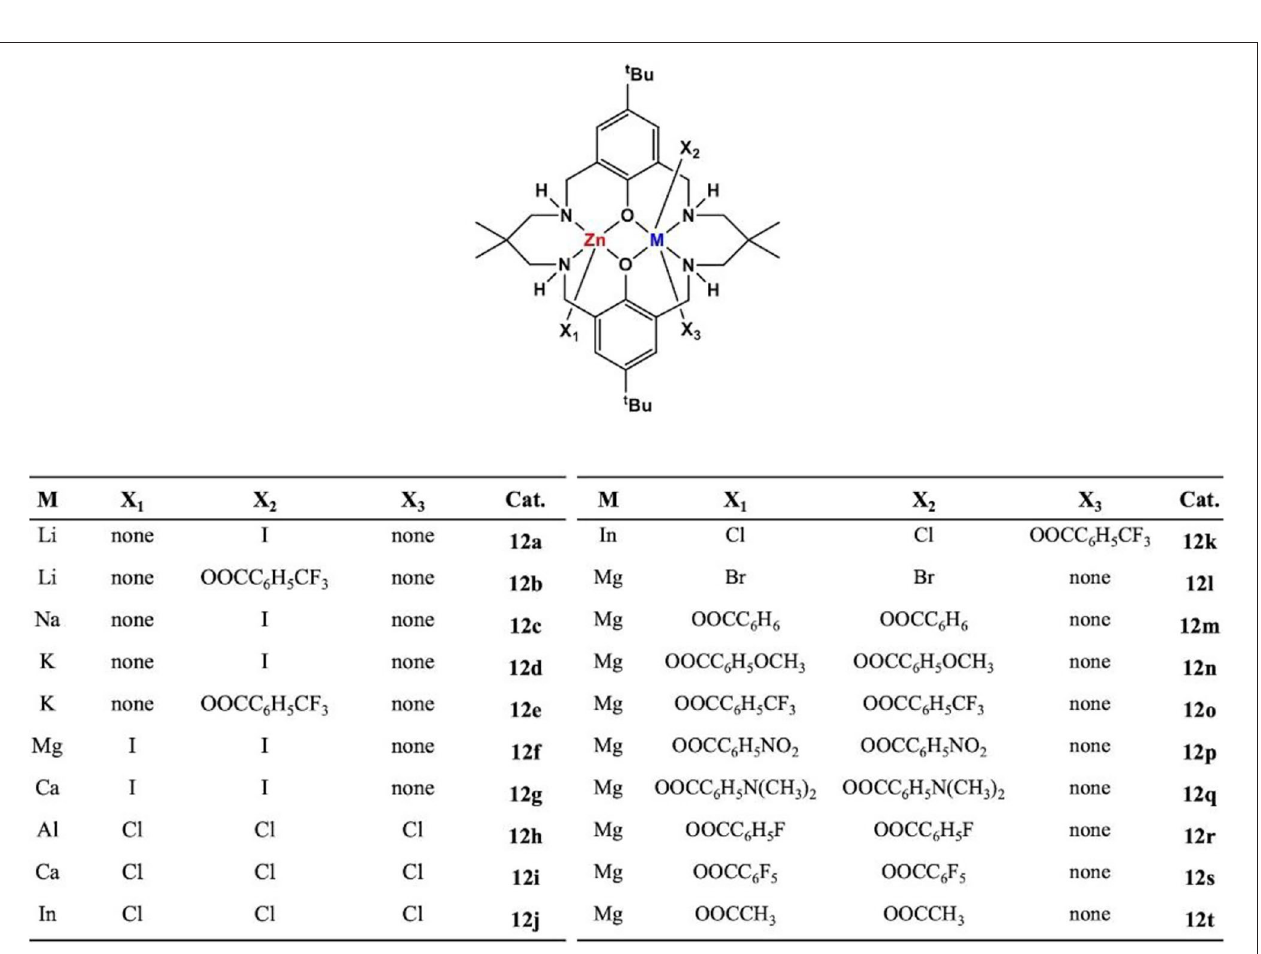
FIGURE 7 | The structures of a series of hetero-Zn/M catalysts based on macrocyclic